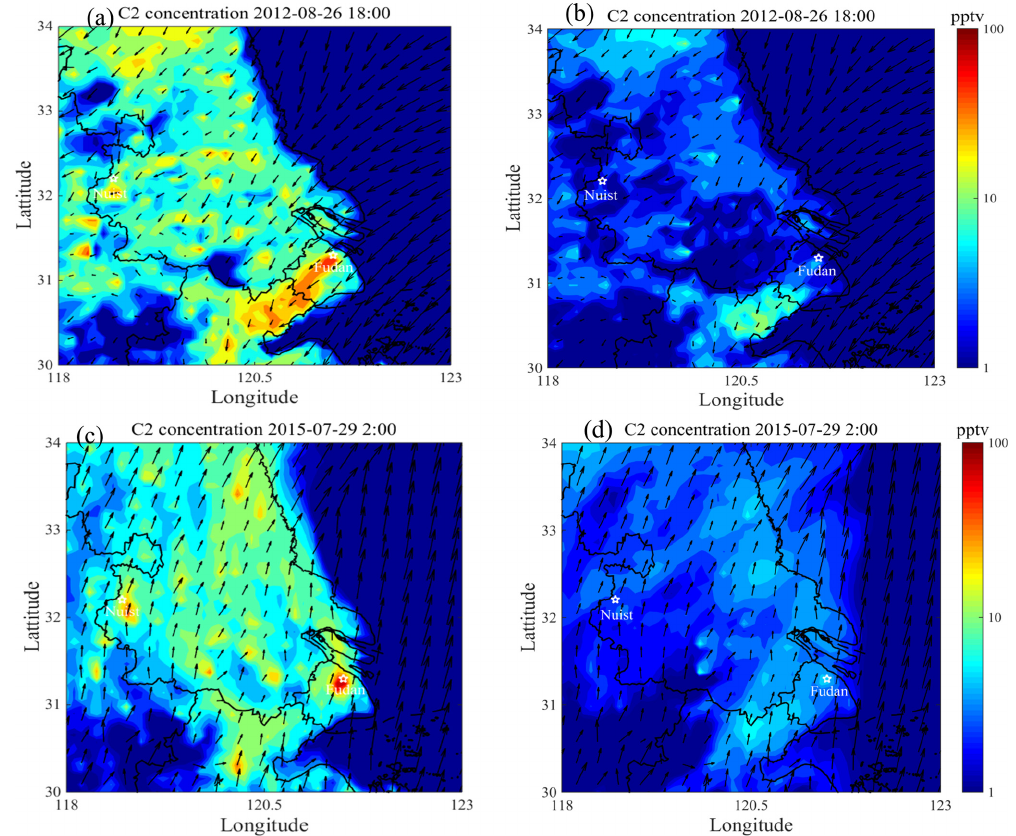
Figure 11. Simulated concentrations of C2-amines at 18:00 on 26 August 2012 and 02:00 on 29 July 2015 using SDR (a, c) and FR (b, d) in domain 3 (horizontal resolution at 9km ×